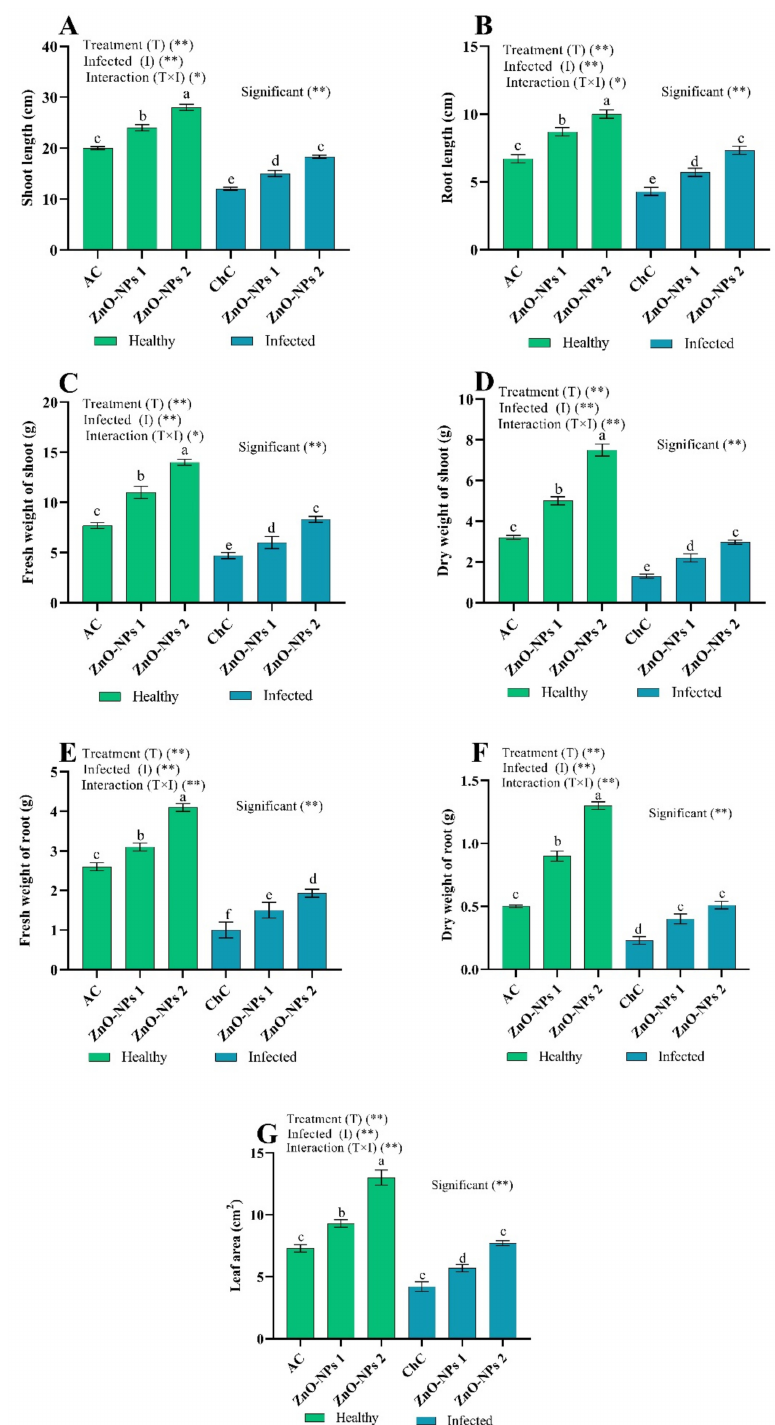
Figure 4. ( A – G ) Effect of foliar spray by ZnO-NPs1 (50 mg/L) and ZnO-NPs2 (100 mg/L) on tomato plant growth indices under absolute control (AC) and Tomato mosaic virus (ToMV) infection (ChC). According to the Fisher test, the different letters (a, b, c, d, e, f) are significantly different at 0.05%. Vertical bars represent the means of 10 independent determinations ± standard error (SE). * and ** suggest significant and highly significant